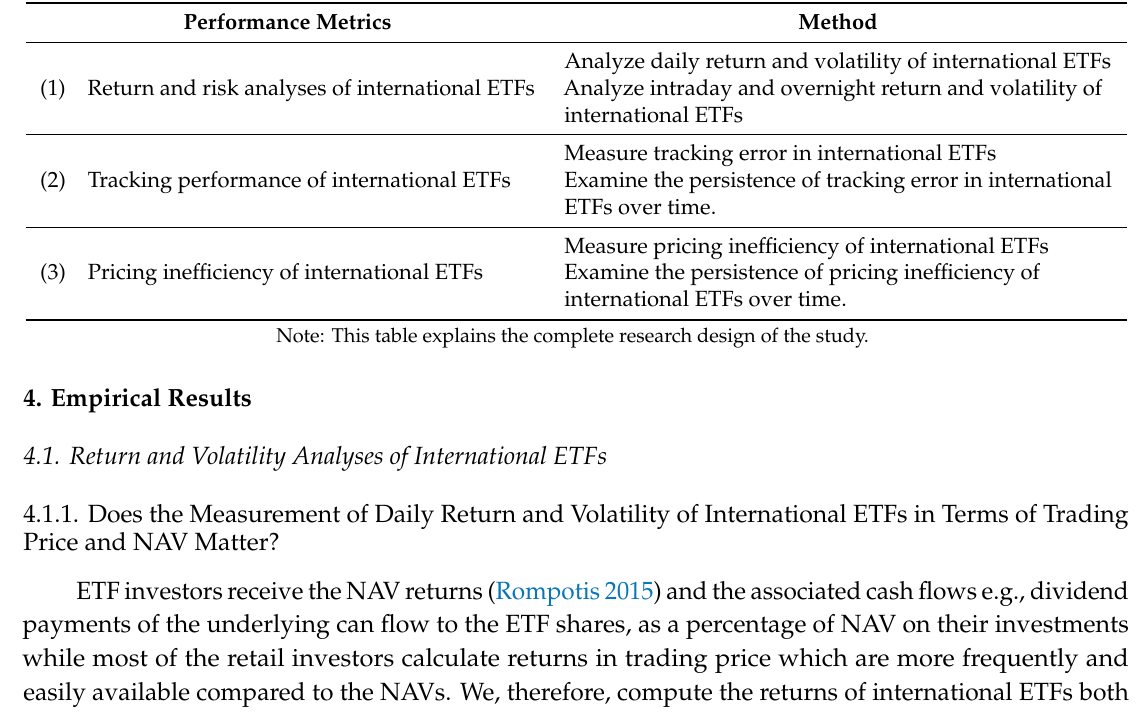
Table 1. Research